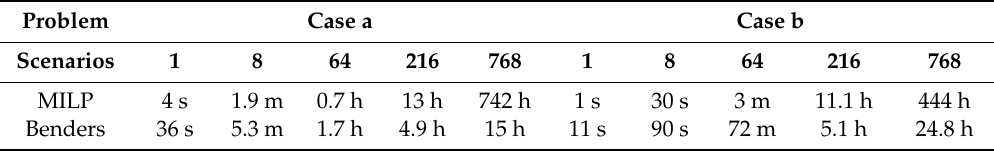
Table 10. CPU Time.